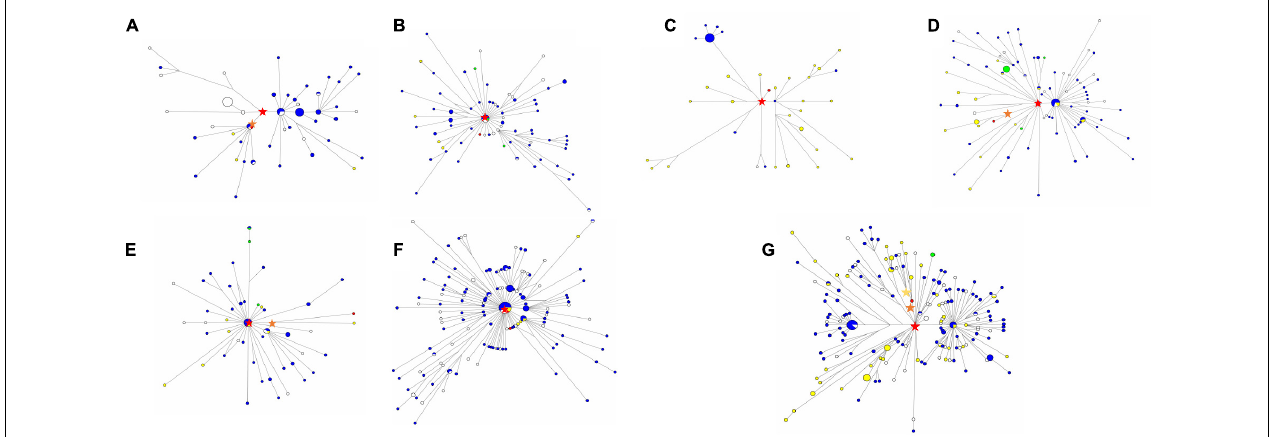
FIGURE 3 | Median-joining networks of star-like Xiabandi (XBD)-related mitochondrial DNA (mtDNA) haplogroups. The median-joining network of haplogroup U2e2a1d (A) , I4a (B) , U1a1c1 (C) , U4a1 (D) , U4c1 (E) , H6a1a (F) , and U2e1 (G) constructed from the complete mitochondrial sequences of both XBD and relevant present-day Eurasians. The red stars mark XBD individuals, the blue plots represent the Europeans, the green plots represent North Asians, the yellow plots represent West and East Asians, and the white plots represent the individuals that are of unknown location. The red stars are the original haplogroup, the orange star in (A) is haplogroup U2e2a1d, the orange star in (E) is haplogroup U4c1 + A827G, the orange star in (D) is haplogroup U4a1 + C7868T + A13773G, the orange star in (G) is haplogroup U2e1 + C2526T + G12618A, and the yellow star in (G) is haplogroup U2e1e.